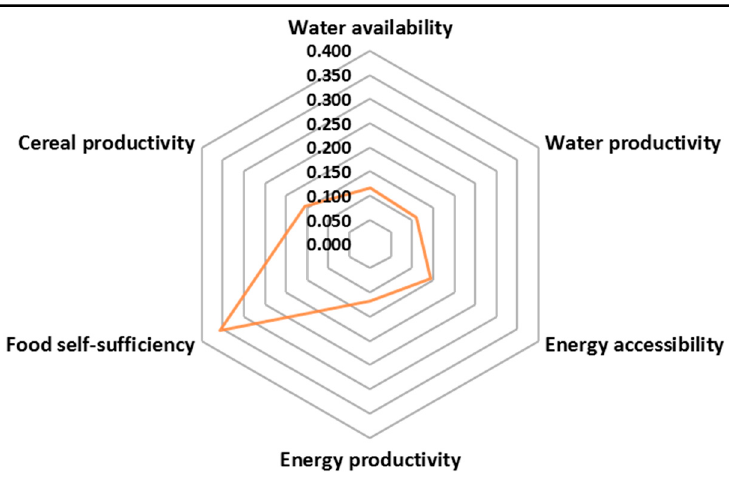
Figure 5. Current WEF nexus performance in southern Africa. The deformed amoeba (the orange centerpiece) is an indicator of an imbalanced and unsustainable resource performance, resulting from a siloed approach to resource use and management. The region should thrive to have a balanced centerpiece, which should be circular in shape.